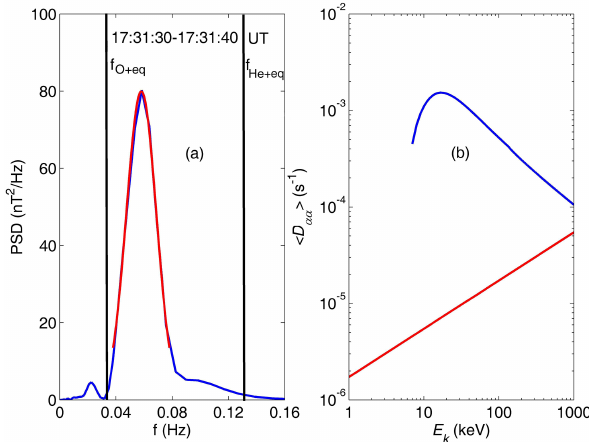
Figure 6. (a) A Gaussian fitting (red solid line) was applied to the dominant frequency band of the observed EMIC waves between 17:31:30 and 17:31:40UT on 3 June 2004. Two black vertical lines denote the He + and O + ion gyrofrequencies at the equatorial plane, respectively. (b) Bounce-averaged pitch angle diffusion rate near the equatorial loss cone (Blue lines) for EMIC waves resonating with ring current ions for the wave shown in (a) . The red curve rep- resents the rate of strong pitch diffusion given by Eq.